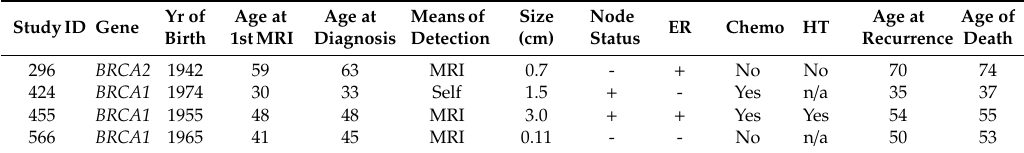
Table 3. Subjects who died of breast cancer.